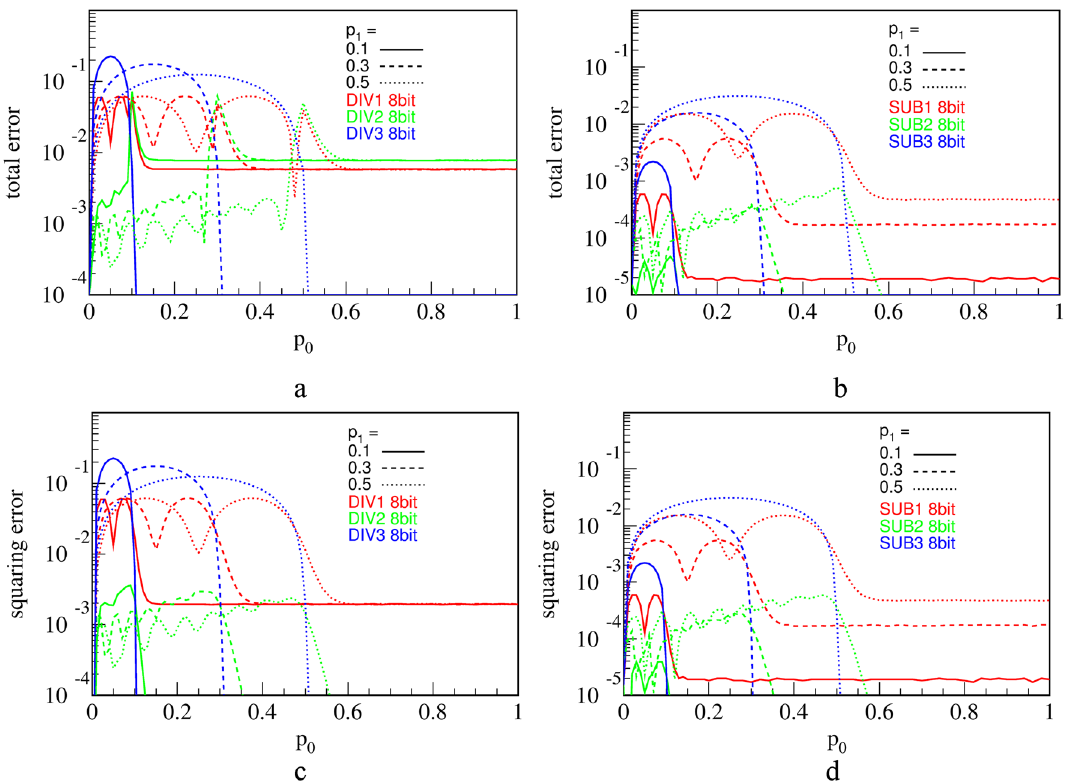
Figure 25. Measured computation errors for composite circuits: total errors of division and subtraction circuits followed by the square circuit (a,b) ; squaring errors of division and subtraction circuits followed by the square circuit (c,d) . Statistical error margins on all figures are on the order of 10 − 6